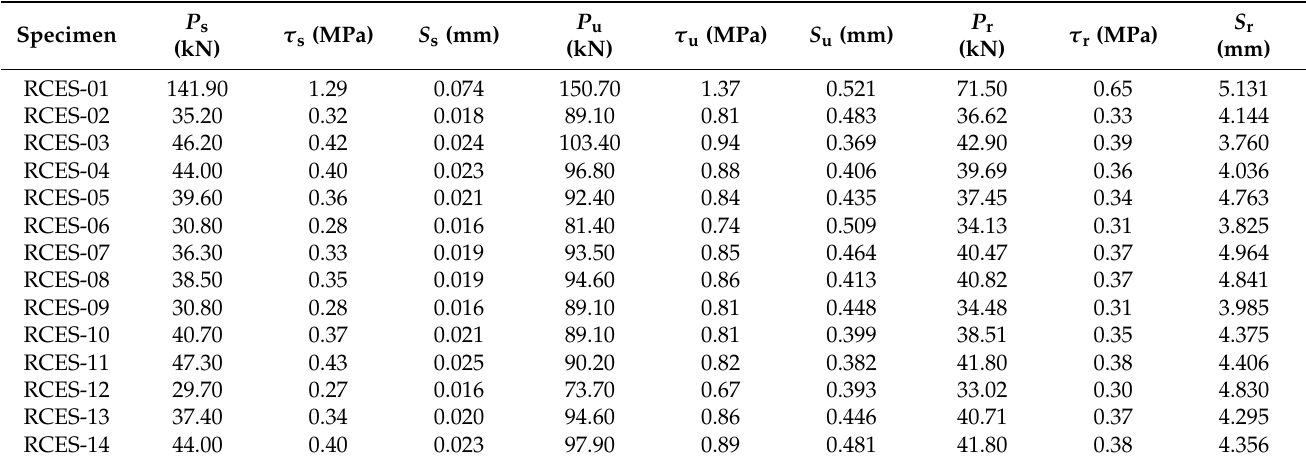
Table 3. Values of characteristic bond